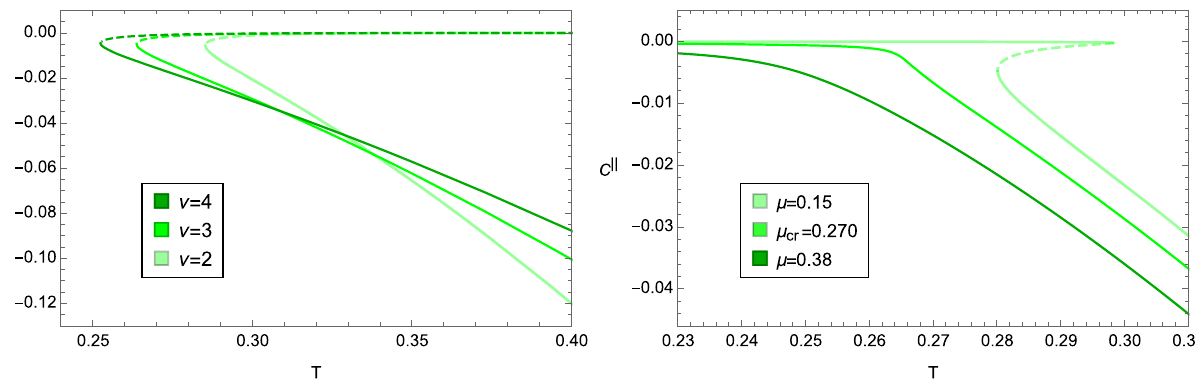
Fig. 6 Left: C || as a function of T for three values of ν for l = 0 . 5 at μ = 0. Right: C || as a function of T for three values of μ at l = 0 . 5 and ν =